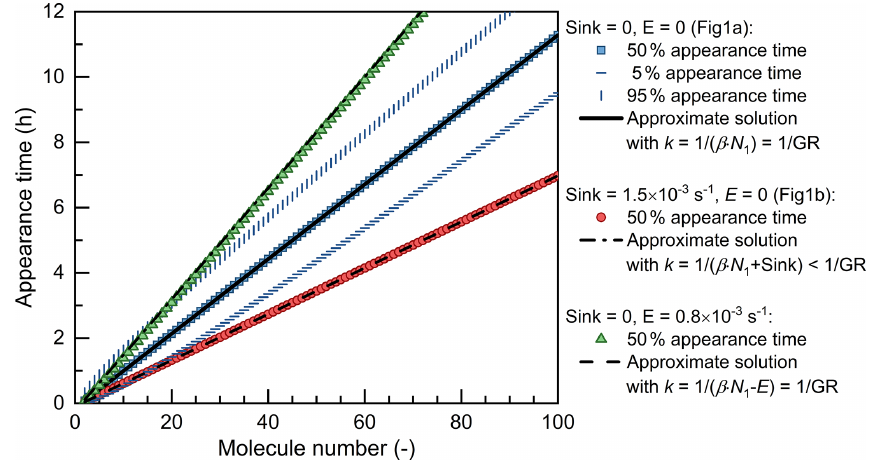
Figure 2. The retrieved appearance time as a function of particle size. The particle size is characterized by the number of molecules contained in each single particle. The scatterplots are the appearance time retrieved from the simulated concentrations. The curves are the approximate solutions for the 50% appearance time, t i = k × (i + ln2 ) , where k is the slope of the curve (see Eqs. 7 and 11). β is the coagulation coefficient (cm 3 s − 1 ) between vapor and particles; N 1 is the vapor concentration (5 × 10 6 cm − 3 ) ; and E is the particle evaporate rate (s − 1 ) . When Sink = 0, the slope of the approximate solution is equal to the theoretical net condensation growth rate (GR, in terms of the molecule number contained in every single molecule), βN 1 − E . However, when Sink > 0, the apparent growth rate, βN 1 + Sink, is higher than the theoretical condensation growth rate, βN 1